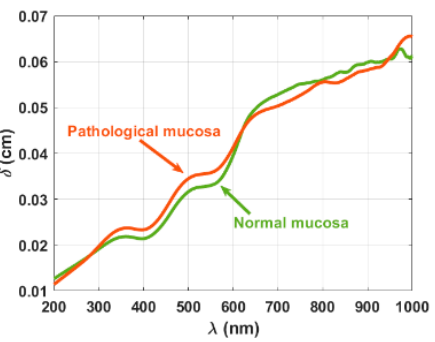
Figure 12. Calculated δ ( λ ) curves for the normal and pathological mucosa.